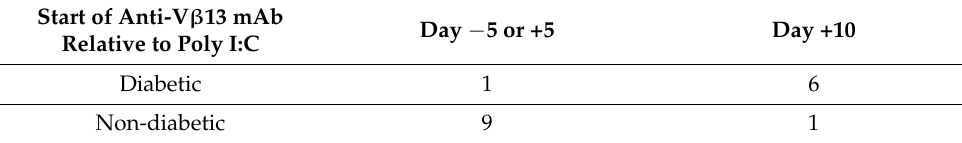
Table 1. Diabetes in LEW.1WR1